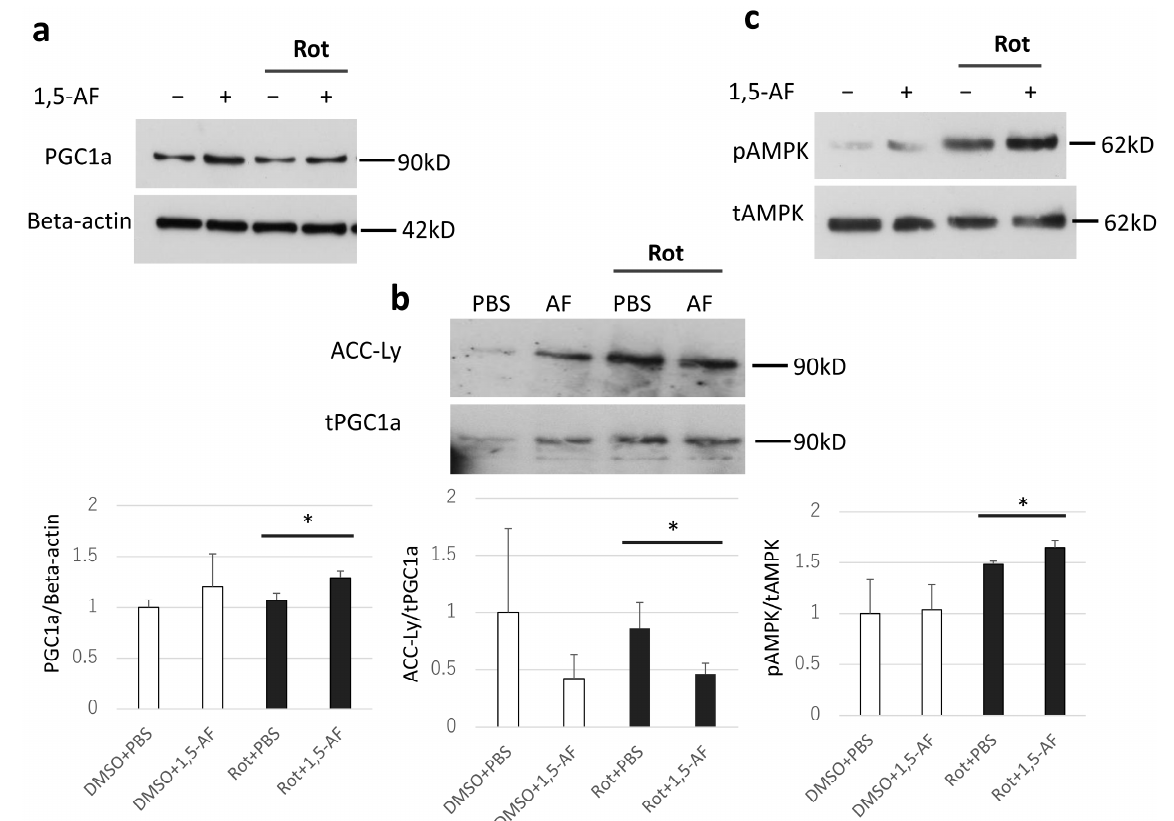
Figure 5. Immunoblotting and quantitative immunoprecipitation evaluated the effects of 1,5-AF treatment on PGC-1 α and AMPK proteins and activities in rotenone-treated PC12 cells. ( a ) Evaluation of PGC-1 α protein level by immunoblotting. In rotenone-treated cells, PGC-1 α protein expression was increased by 1,5-AF treatment. ( b ) Evaluation of PGC-1 α acetylation assays. In rotenone-treated cells, deacetylated PGC-1 α was increased by 1,5-AF treatment. ( c ) Total AMPK and phosphorylated AMPK were evaluated by immunoblotting. In rotenone-treated cells, the ratio of phosphorylated AMPK to total AMPK was increased by 1,5-AF treatment. All data are expressed as the mean ± standard error of the mean of quadruplicate experiments. * p < 0.05. 1,5-AF, 1,5-anhydro-D-fructose; ACC-Ly, acetylated lysine; DMSO, dimethyl sulfoxide; Met, metformin; pAMPK, phosphorylated AMP-activated protein kinase; PBS, phosphate-buffered saline; PGC-1 α , peroxisome proliferator-activated receptor- γ coactivator 1 α ; Rot, rotenone; tAMPK, total AMP-activated protein kinase; tPGC1a, total PGC-1 α . Note: tPGC1a in panel ( b ) represents PGC-1 α in samples immunoprecipitated with anti-PGC-1 α antibody, whereas PGC1a in panel ( a ) represents PGC-1 α in cell lysates that were not subjected to im- munoprecipitation.